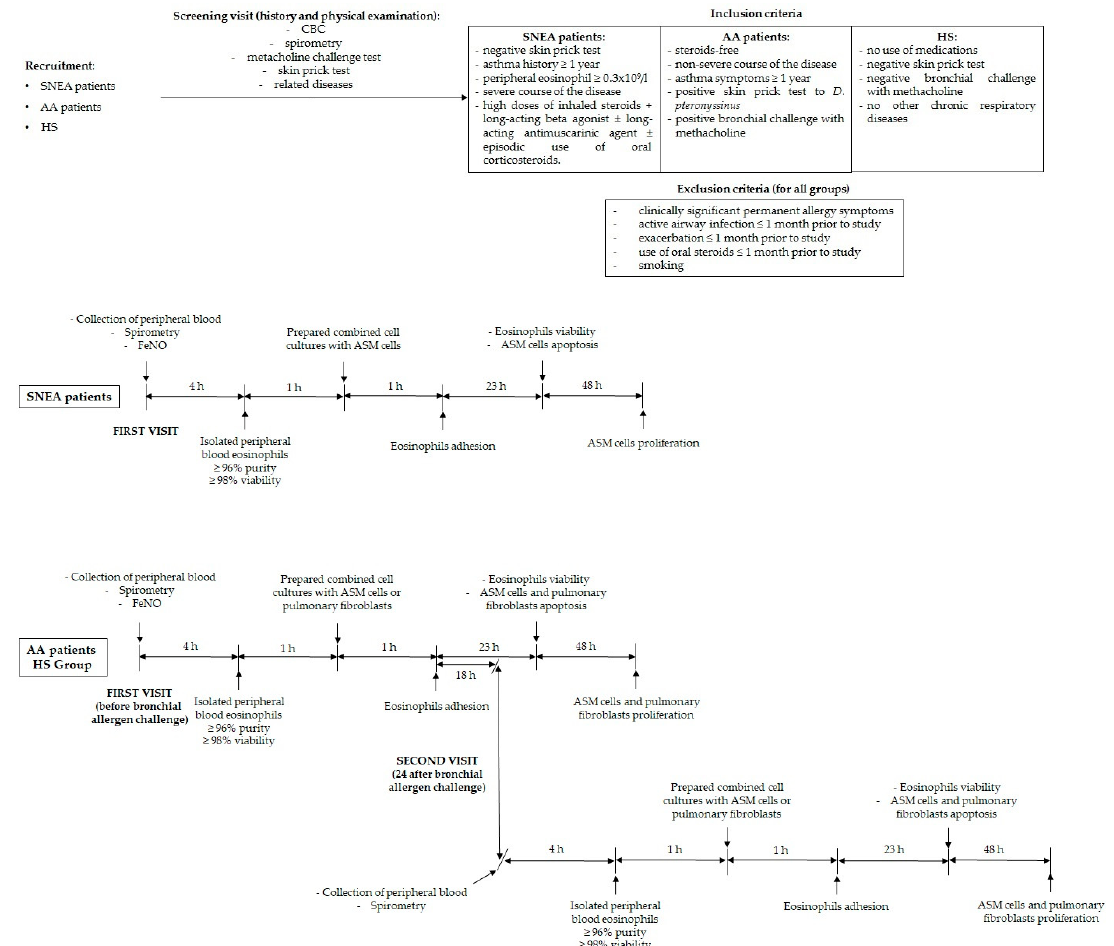
Figure 1. Experimental study design. CBC—Complete blood count; SNEA—Severe non-allergic eosinophilic asthma; AA—Allergic asthma; HS—Healthy subjects; FeNO—Fractional exhaled nitric oxide; ASM—Airway smooth muscle.